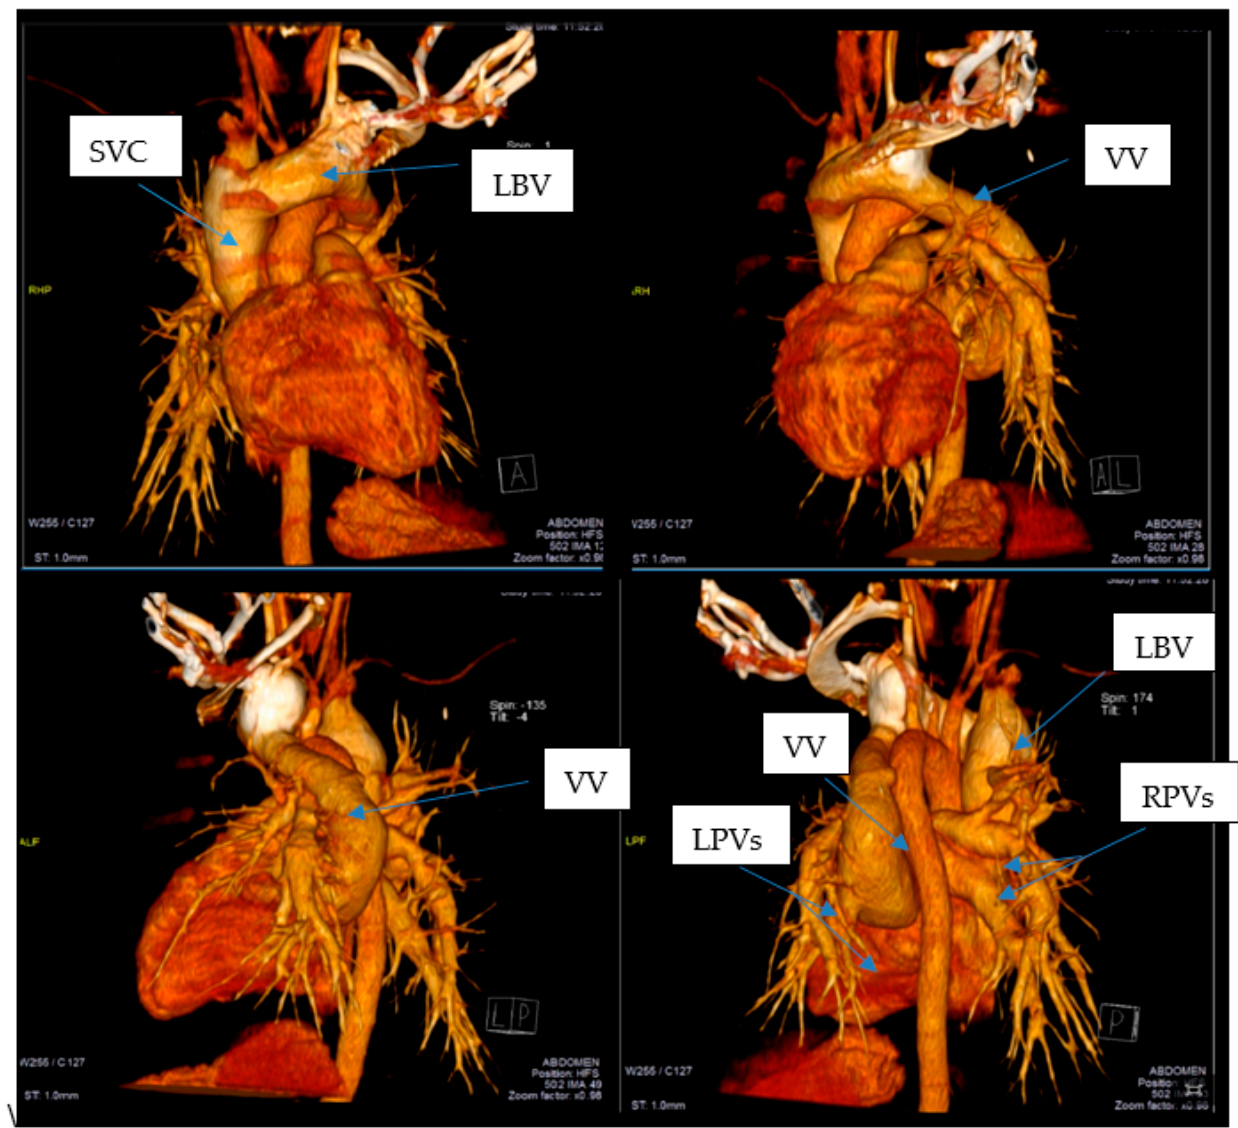
Figure 2. All four pulmonary veins are ending into a collecting canal that opens into the left brachiocephalic vein that drains into the superior vena cava. SVC—superior vena cava; LBV—left brachiocephalic vein; VV—vertical vein; LPVs—left pulmonary veins; RPVs—right pulmonary veins. Arrows shows the great vessels related to the heart.